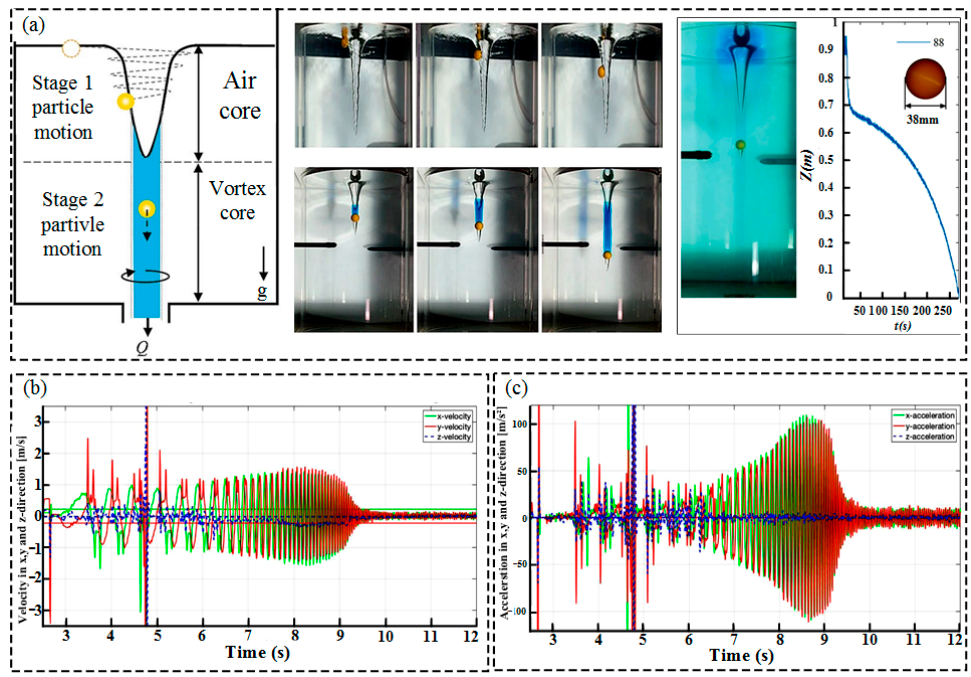
Figure 7. Particle motion is driven by surface vortex. ( a ) Particle motion. ( b ) x-y and z velocities. ( c ) Acceleration in x, y, and z directions. (Reprinted with permission from Ref. [73]. 2019, Springer Nature).